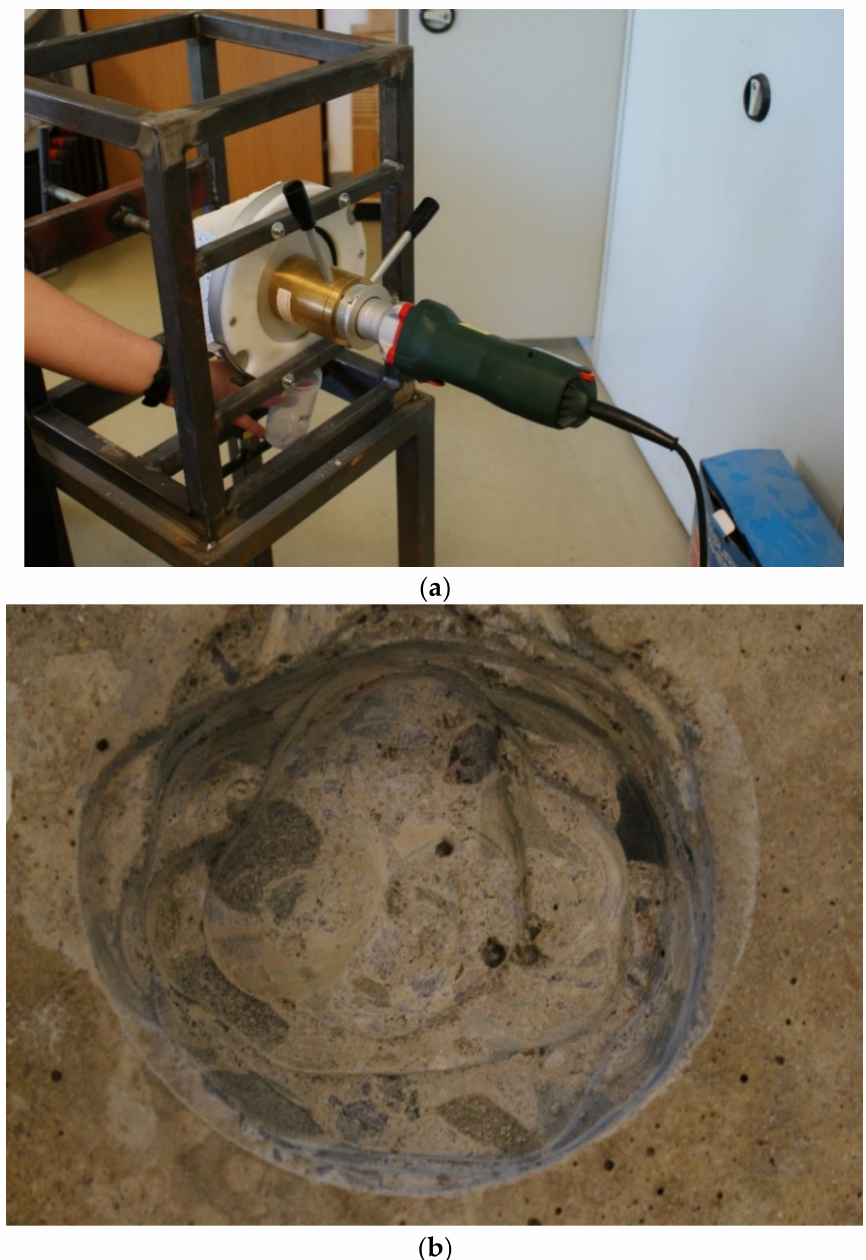
Figure 2. ( a ) Sampling of the exposed sample using a Profile Grinder; ( b ) the resulting layered drill in the concrete